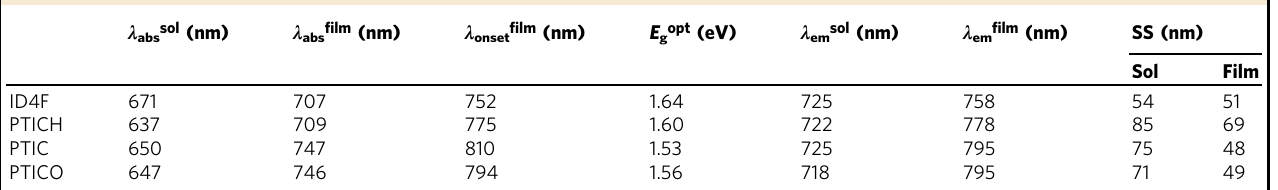
Table 1 Optical properties of ID4F and